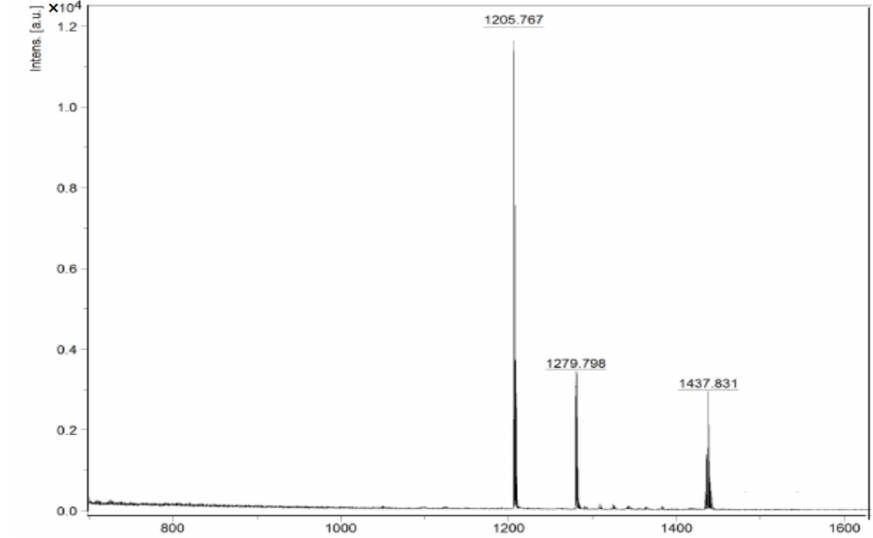
Figure 3. Mass spectra of TVi 7iso